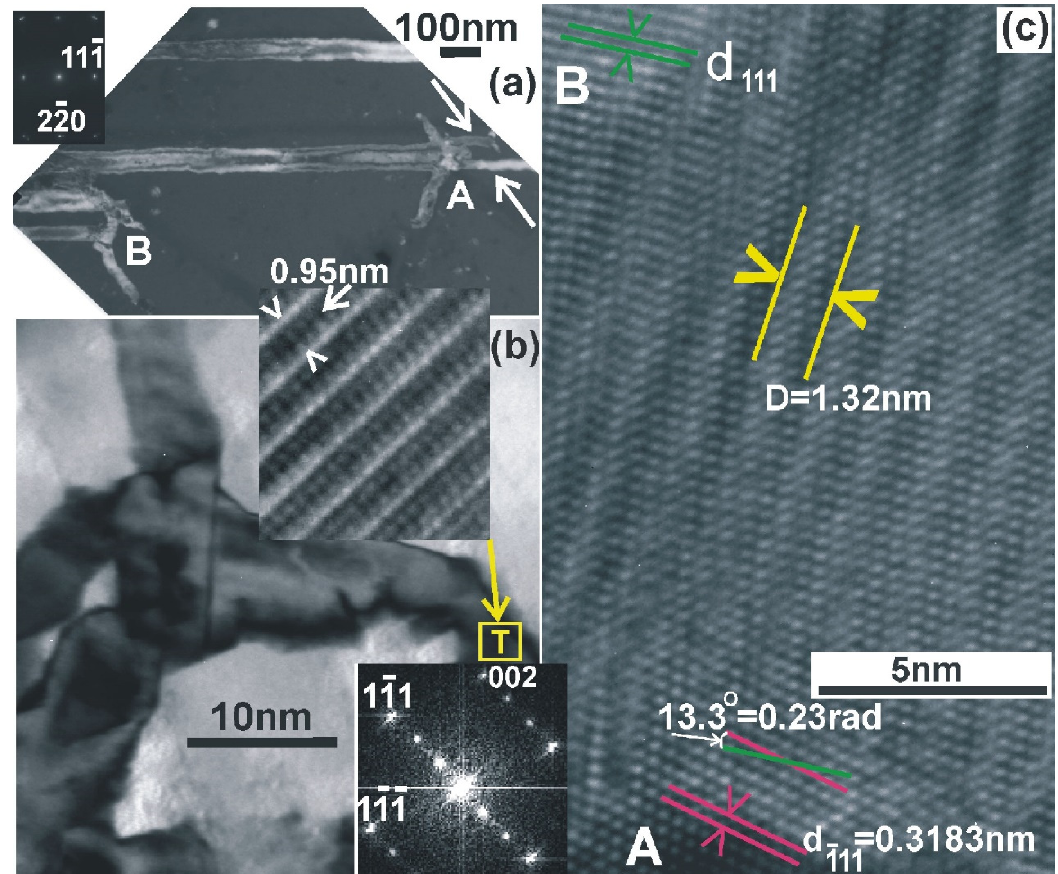
Figure 10. ( a ) DF-PVTEM micrograph showing disturbed nonlinear branches at the side-walls of the whiskers A and B. In the whisker A after the formation of the disturbed branches, the whisker was split into two parallel ones. In the case of whisker B, the growth was stopped. Both the whiskers were fast [111] types viewed in the (220) section. ( b ) The nonlinear branches consist of highly defected grains. In the area denoted by the letter T, Moiré pattern is observed with periodicity D 111 = 3d 111 ; these are formed by double diffraction of the electron beam in the matrix and an overlapping (111) twin; when viewed in the (110) section, this is confirmed by the Fast Fourier Transform shown in the inset. ( c ) Two overlapping grains, slightly misoriented A and B, are viewed in the (110) section, having the common (111) reflection in strong contrast. Moiré pattern of rotation type is observed, having periodicity of D 111 = 1.38 nm, which corresponds to a misorientation of 1.34°. Very often, grains with different orientations overlap, giving Moiré pattern as shown in Figure 10c. The grain A viewed in the exact (110) section overlaps with the grain B